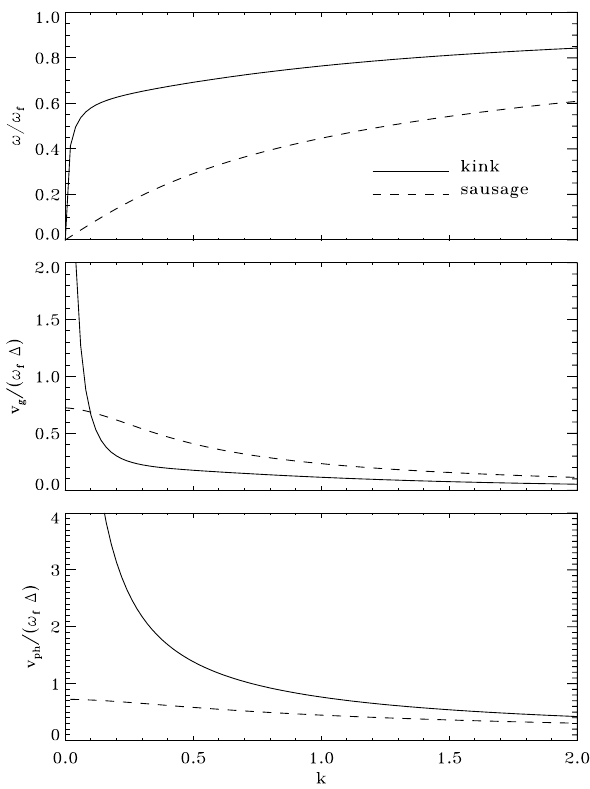
Fig. 5. Eigenfunctions corresponding to the “sausage” mode.